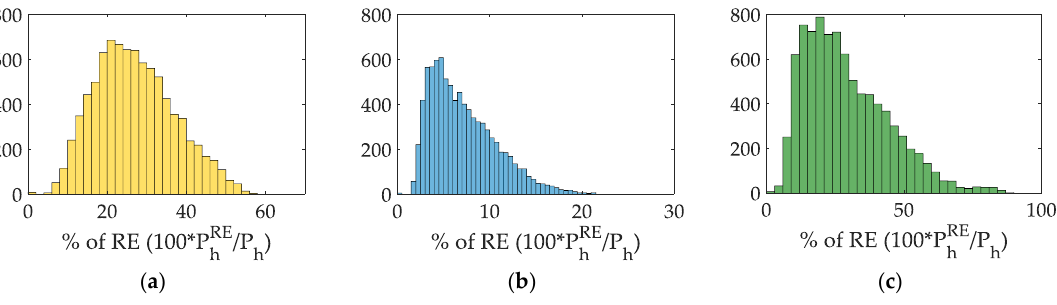
(cid:0) (cid:1) E RE / E h , ( a ) in Spain; h